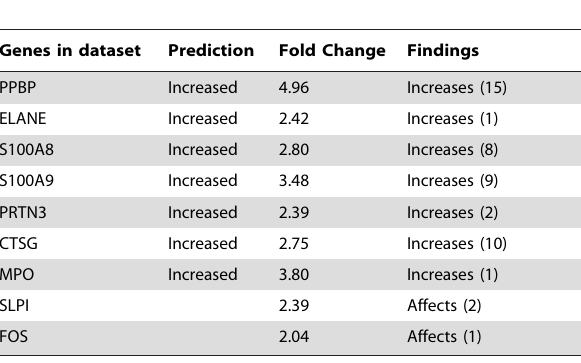
Molecules differentially expressed in the pathway with the highest Z-score in Table 4, showing gene expression changes for individual molecules and the predicted impact on the associated annotated function (inflammatory